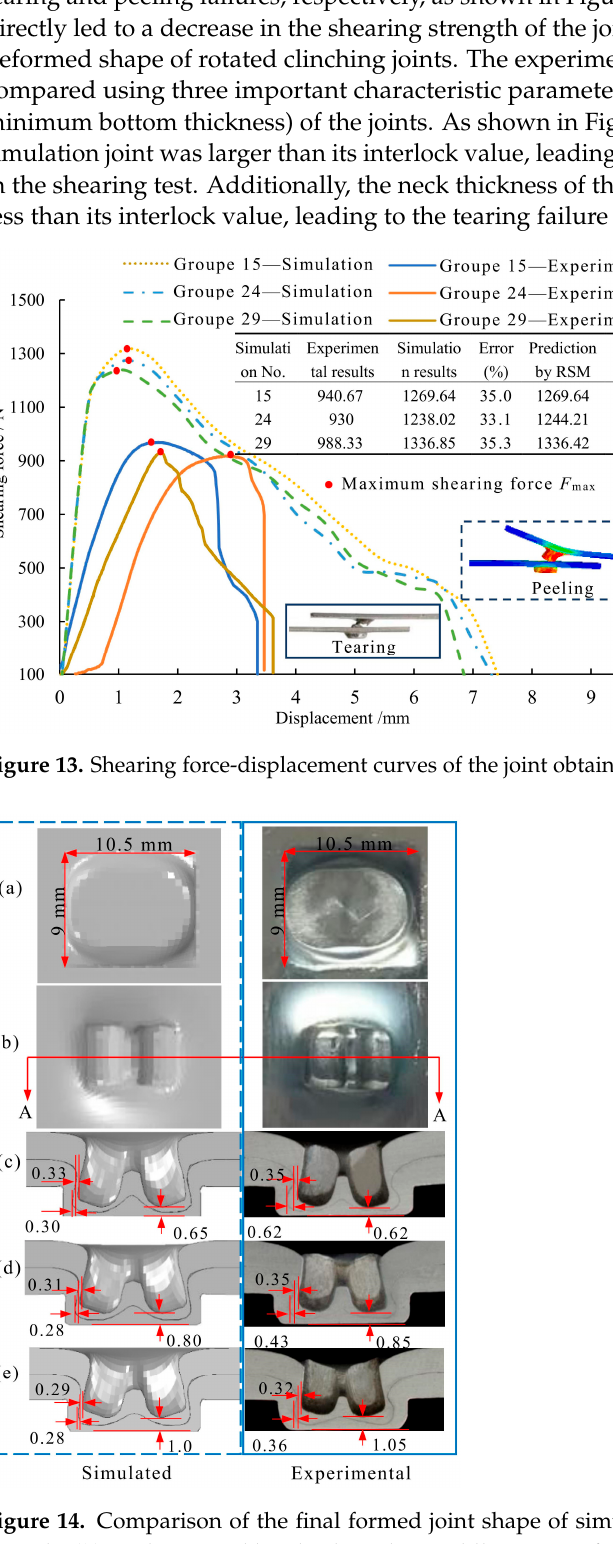
Figure 14. Comparison of the final formed joint shape of simulation and experiment: ( a ) on the die side, ( b ) on the rotated head side and in middle section of XZ of ( c ) group 15, ( d ) group 24 and ( e ) group 29.